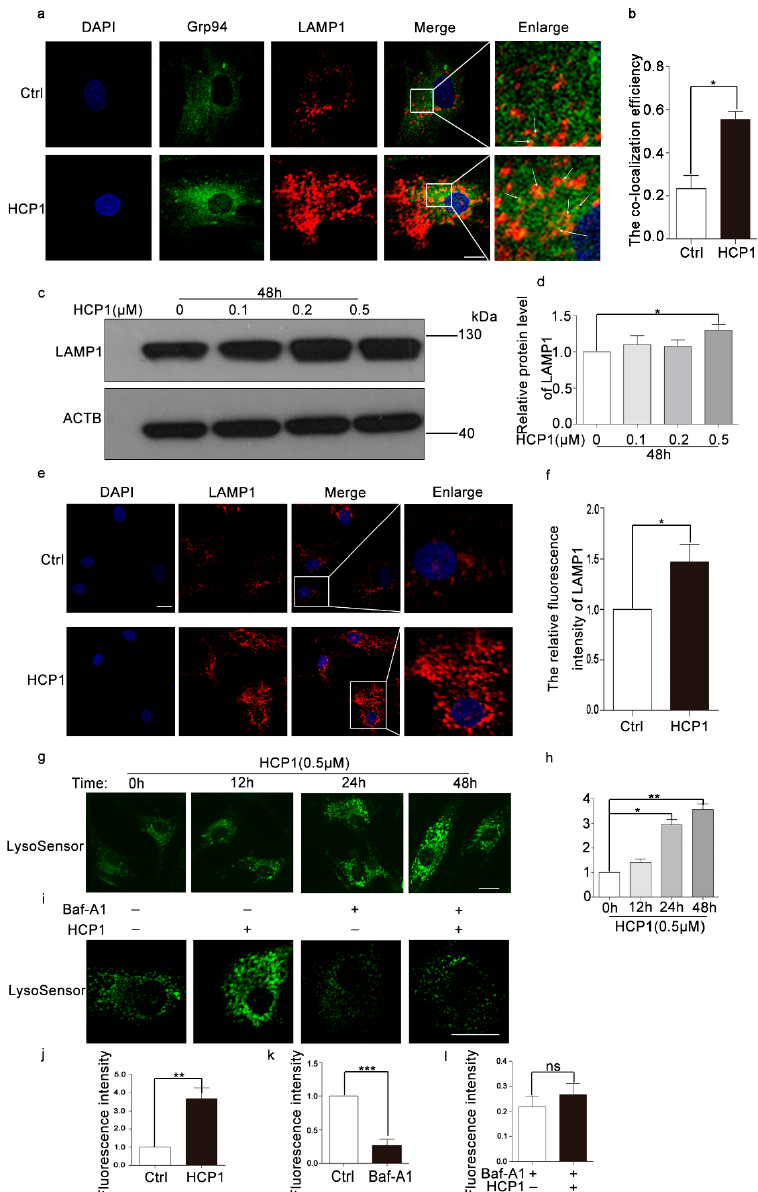
Figure 6. HCP1 up-regulated the activity of lysosome by activating v-ATPase. ( a , b ) HDFs were treated with DMSO or HCP1 (0.5 μ M) for 48 h, Immunofluorescence analysis the interaction of Grp94 and LAMP1. White arrows indicate colocalized regions. ( c – f ) DMSO or HCP1 (0.1, 0.2, 0.5 μ M) treated senescent HDFs for 48 h, Western blot and Immunofluorescence analysis of the protein levels of LAMP1. ( g , h ) After HCP1 (0.5 μ M) treated senescent cells for 12 h, 24 h, 48 h, the lysosomal probe Lysosensor Green DND-189 was used to detect the H+ level in the lysosome. ( i – l ) HCP1 (0.5 μ M) and/or Baf-A1 (20 nM) treated senescent HDFs for 48 h, a confocal laser scanning microscope 700 was used to detect the fluorescent intensity of Lysosensor Green DND-189. Scale bar: 20 μ m. Data are presented as means ± SEM, * p < 0.05, ** p < 0.01, *** p < 0.001, n = 3. Lysosomal acidity is closely related to lysosomal activity. Wang et al. demonstrated a decrease in lysosomal activity with age, as well as a decrease in acidic vacuoles [28]. We hypothesized that lysosomal activity is altered during HCP1 inhibition of HDFs